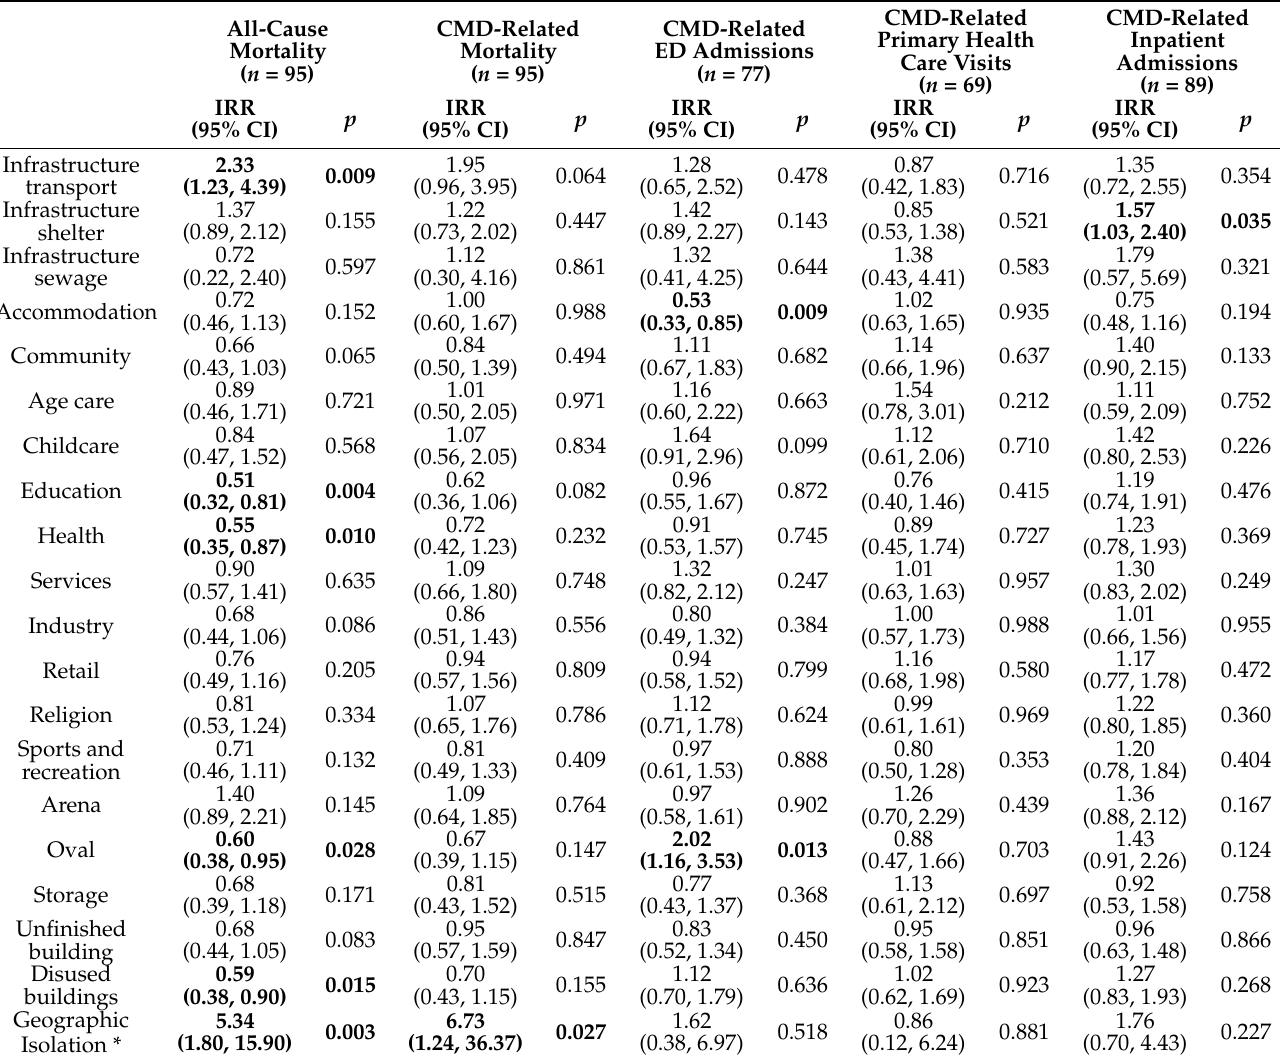
Table 2. Univariable regression of built environment features on all-cause mortality and cardiometabolic-related mortality and